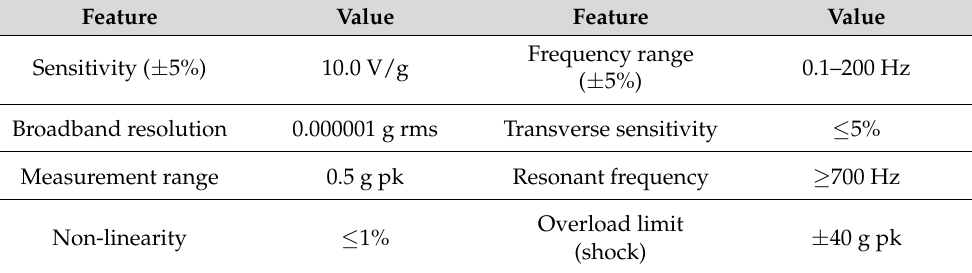
Table 1. Characteristics of the piezoelectric accelerometers PCB